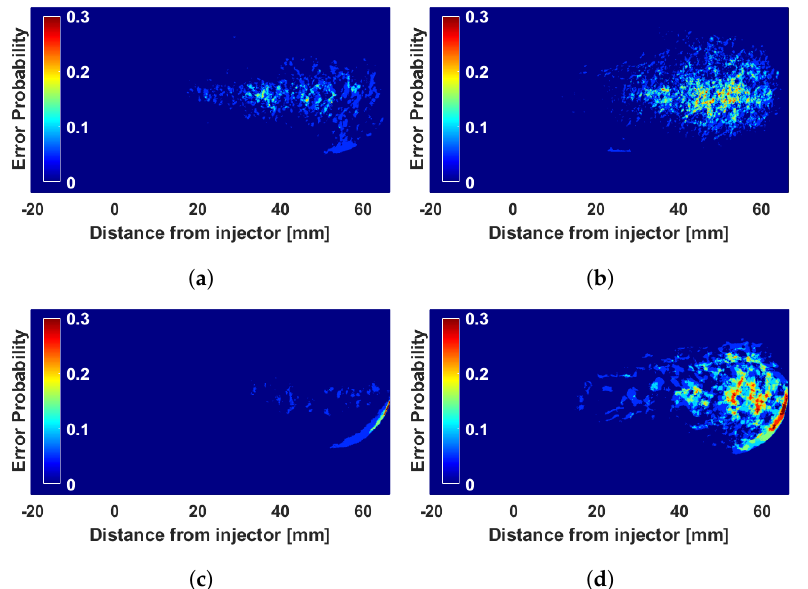
Figure 14. Error zone probability maps for non-physical solutions. t = 2900 µ s. ( a ) Red–blue filters and high soot; ( b ) red–green filters and high soot; ( c ) red–blue filters and low soot; ( d ) red–green filters and low